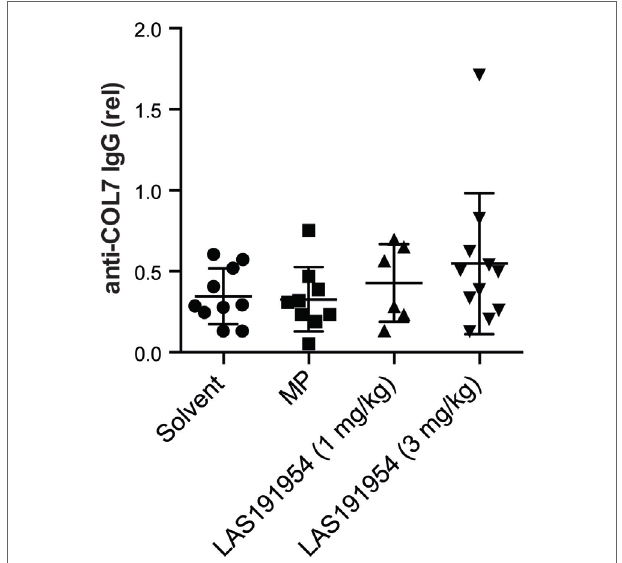
FigUre 2 | Circulating anti-COL7 IgG remains unaltered after treatment with either LAS191954 or methylprednisolone. At randomization (week 0) and at the end of the treatment (week 6), serum was obtained from selected mice. The graph shows the mean and STW of the relative serum concentration of anti-COL7 IgG antibodies at week 6 in relation to week 0. In all groups, a decrease of COL7-specifig IgG was noted, with no statistically difference observed among the groups. Data are based on 6–11 mice per group. Each dot represents the data from one animal. Statistical analysis was performed using one-way